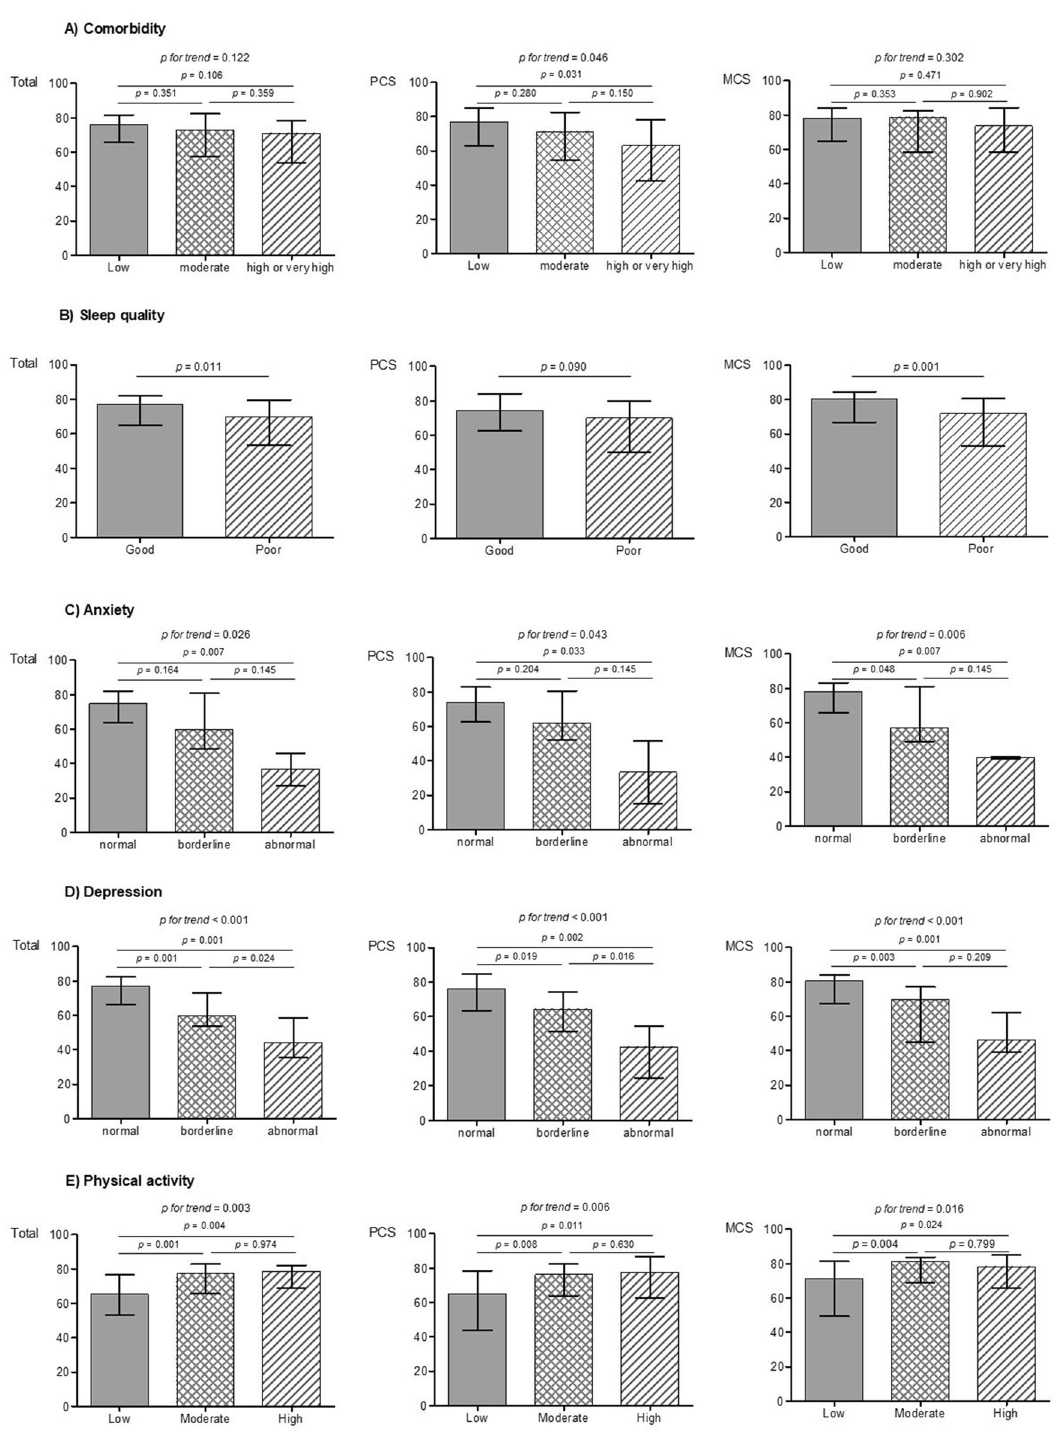
Figure. 1. Distribution of health-related quality of life according to comorbidities ( A ), sleep quality ( B ), anxiety ( C ), depression ( D ), and physical activity level ( E ) among patients with diabetic kidney disease. Bars and error bars indicate the median value and interquartile range, respectively. Abbreviations: CCI Charlson Comorbidity Index, MCS mental component summary, SF-36 Short Form 36 of life Health Survey Question, SQ sleep quality, PA physical activity, PCS physical component